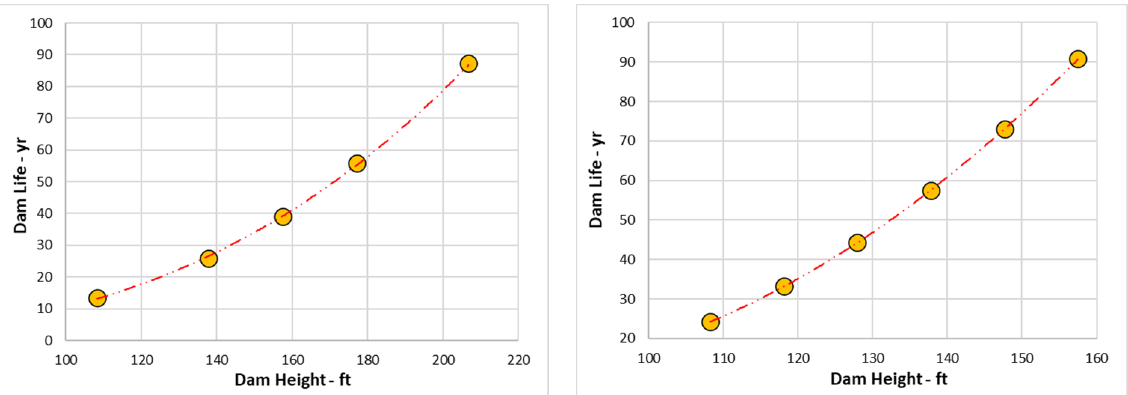
Figure 10. Dam life vs. Dam heigh relation; dam-A (left) and dam-B (right).